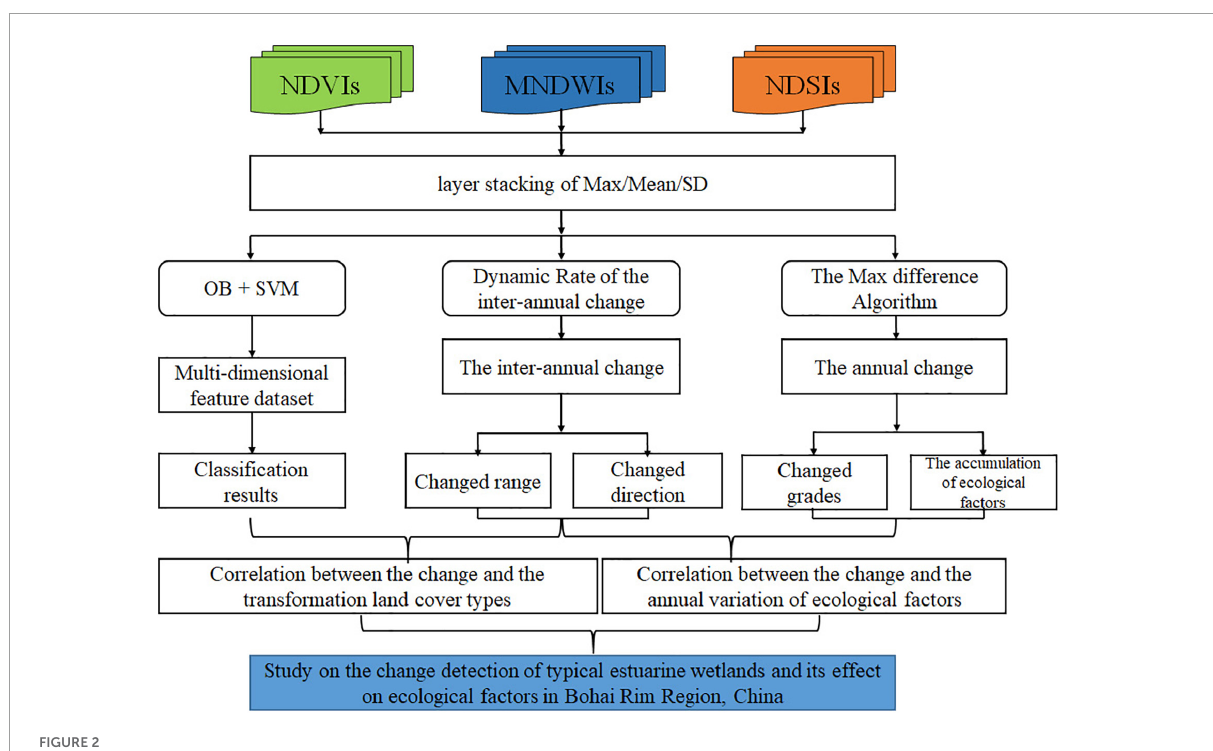
FIGURE2 The flowchart of the change